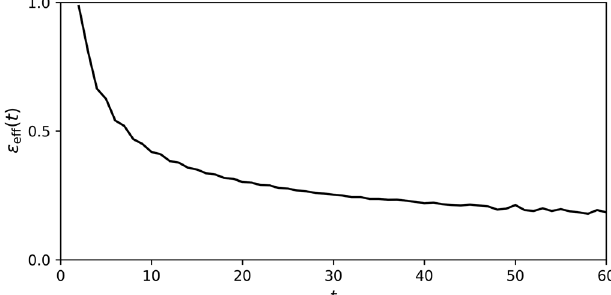
ð t Þ defined in eff